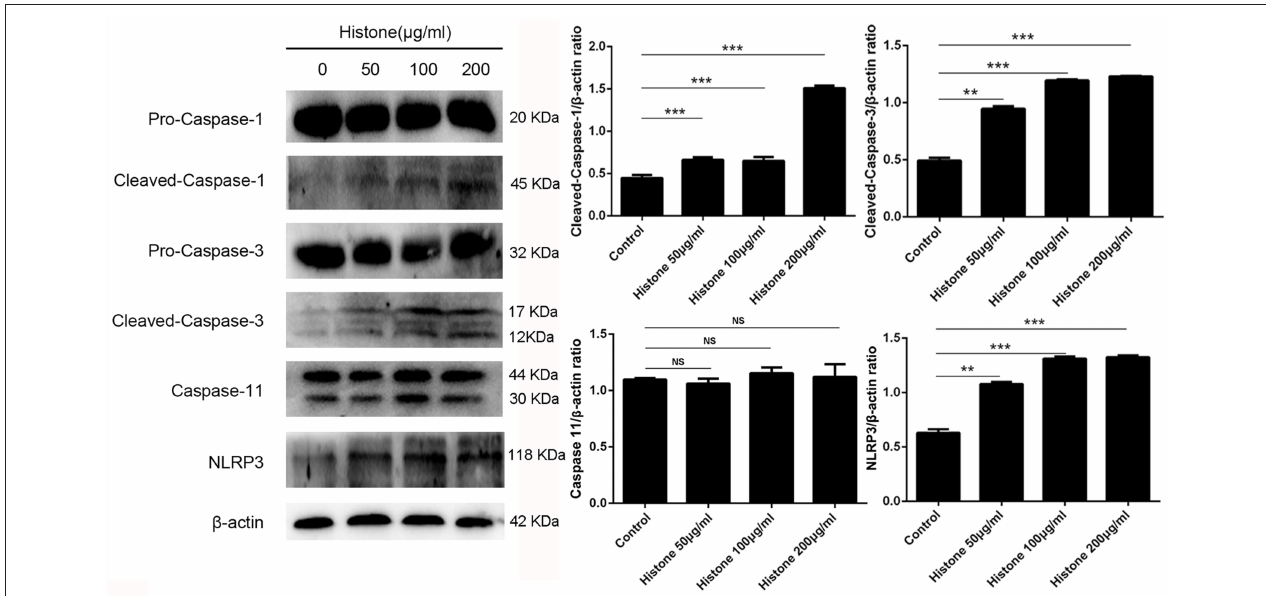
FIGURE 7 | Histone induce BMECs pyroptosis is dependent on activations of caspase 1, caspase 3 and NLRP3. BMECs were incubated with stimulated histone for 16h, and the activities of these proteins were determined by western blotting. Date are presented as mean ± SEM ( n = 5). P -values of < 0.05 were considered significant (** P < 0.01, *** P < 0.001, and “ns” means not